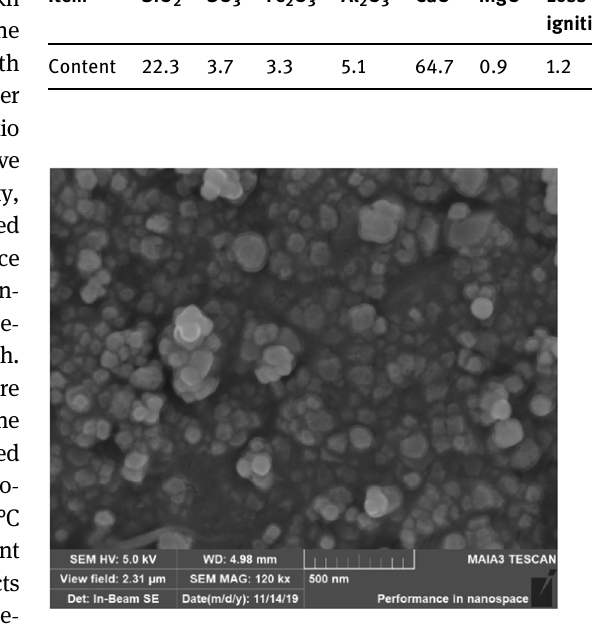
Figure 1: SEM image of NC